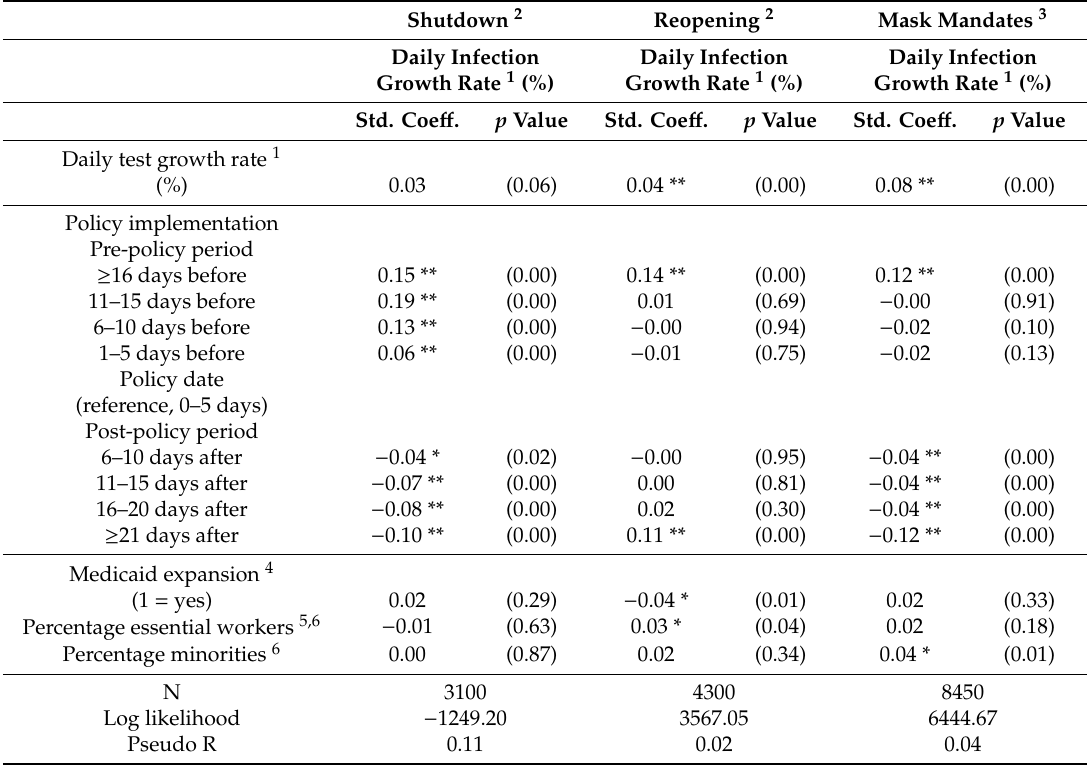
Table 3. COVID-19 US state policies: event study model results, February through August 2020 (standardized coe ffi